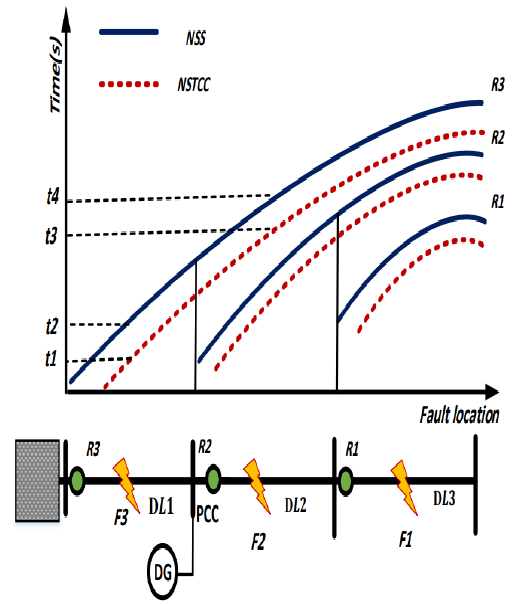
Figure 5. Proposed Nonstandard Time–Current Characteristics with variable coefficient A (NSTCC) and Nonstandard Scheme with constant coefficient A (NSS).